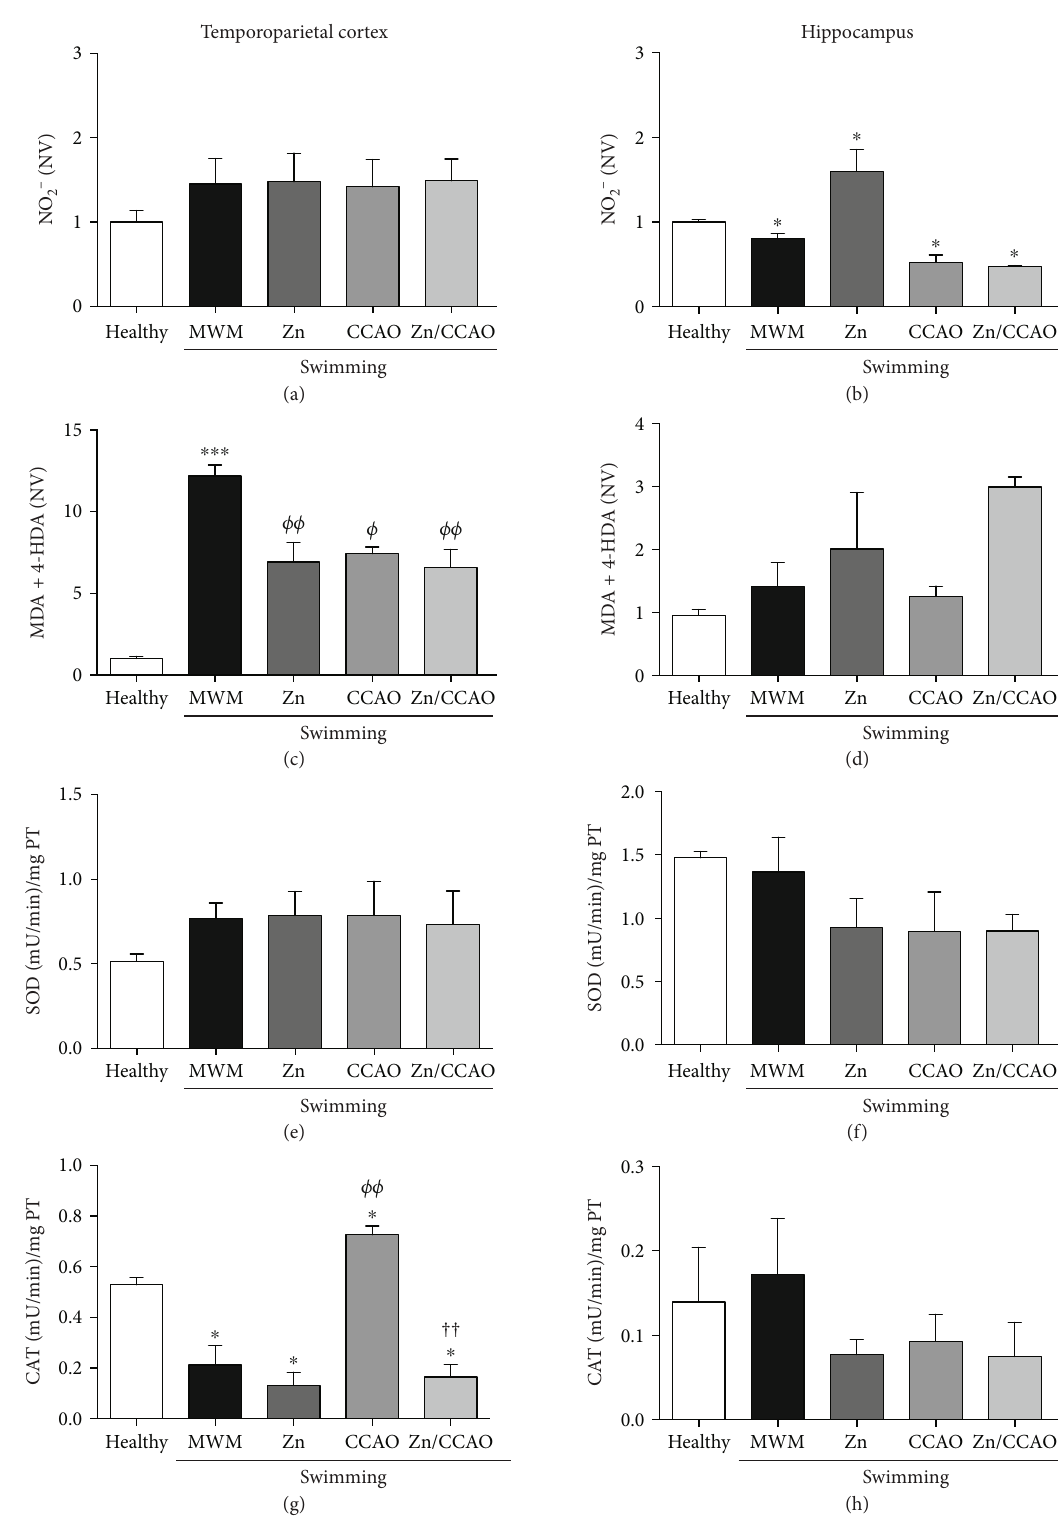
Figure 4: The subacute prophylactic zinc administration and swimming prevented nitrosative stress and increased catalase activity on day 12 postreperfusion only in the temporoparietal cortex of rats with 30min CCAO. The values are mean ± SEM ( n = 5 ) and analyzed with one- way ANOVA and Dunnett ’ s post hoc multiple comparison test. P < 0 : 05 , ∗ compared with the Healthy group, Φ compared with the MWM group, and † compared with the CCAO group; NV: normalized